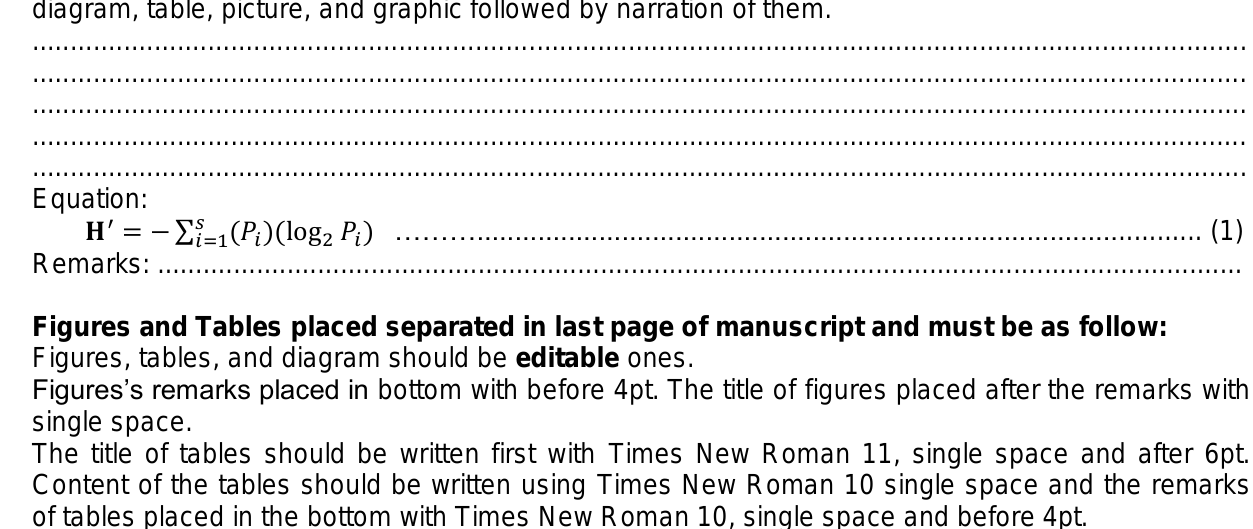
Table 1. Effects of plant growth regulator types and concentrations on embryogenic callus induction